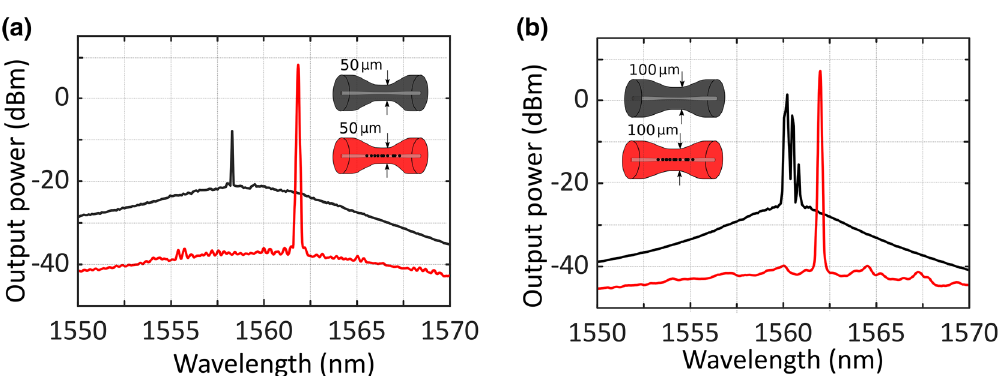
Figure 5. ( a ) Reflection spectrum of the 50 µm-waist micro-drilled tapered fiber. ( b ) Reflection spectrum of the 100 µm-waist micro-drilled tapered fiber.